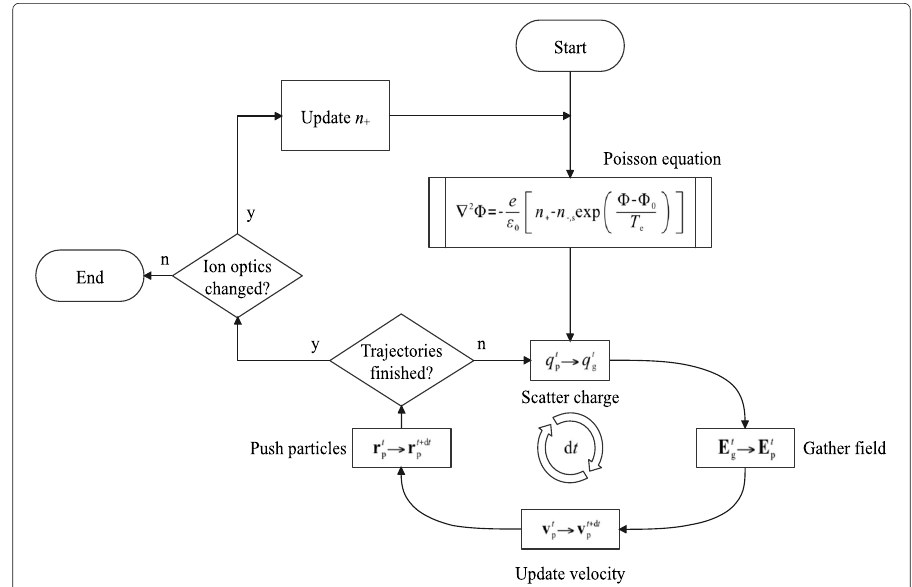
Fig. 4 Flow chart of the 2D ion trajectory